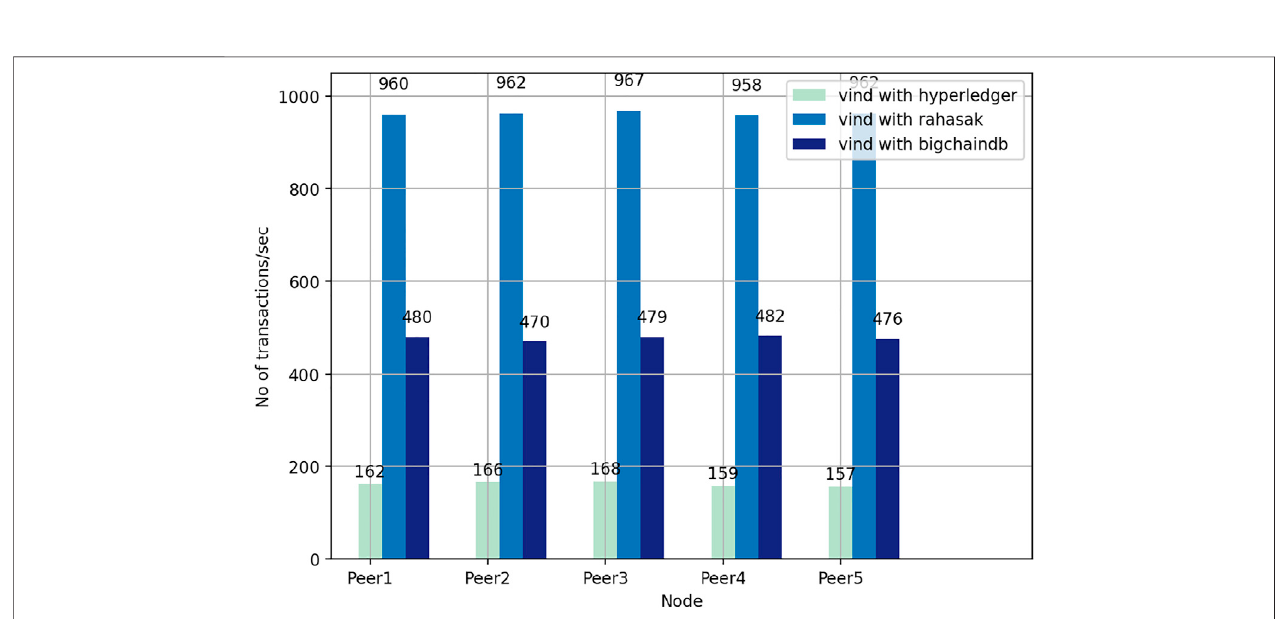
FIGURE 5 | Invoke transaction result of the Vind platform with different blockchain ledgers.